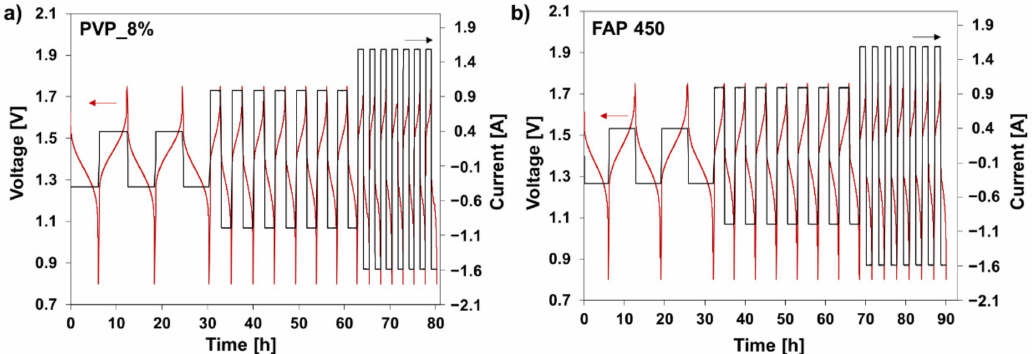
Figure 6. Cycling curves (90 h) of the VRFB single cell (20 cm 2 of active area) assembled with PVP_8% ( a ) and FAP450 ( b ), cut off voltage: 0.80 and 1.75